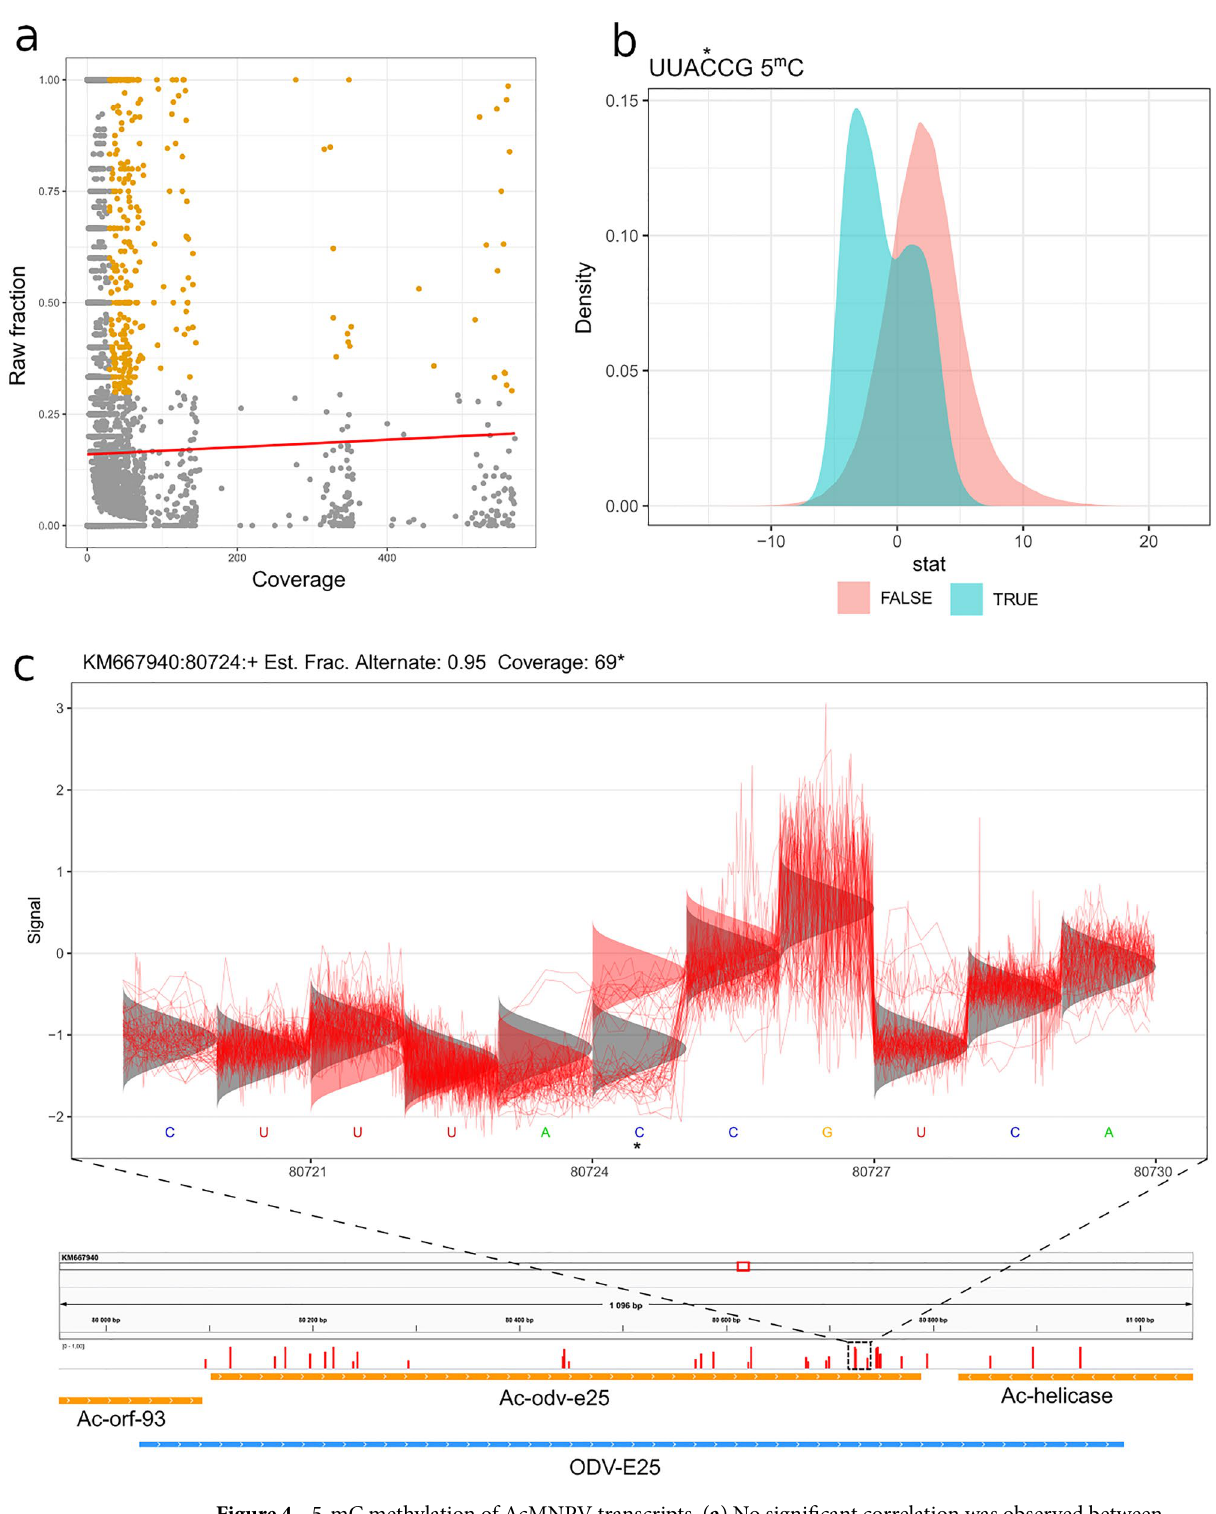
Figure 4. 5-mC methylation of AcMNPV transcripts. ( a ) No significant correlation was observed between the coverage and the number of methylated nucleotides in the raw fraction. Yellow dots indicate positions designated for further analysis. The plot was made with the ggplot2 r package 53 . ( b ) Test statistics of UUAC*CG sequence (methylated positions are labelled by asterisks). This panel plots a distribution of test statistics for motif-matching and non-motif-matching sites for all of the provided motives. The plot was made with the ggplot2 r package 53 . ( c ) A putative methylated cytosine of the readthrough part of ODV-E25 transcript (5-mC labelled by asterisk). The red curves indicate the electric signals, while the densities indicate the alternative signal levels. The plot was made with the tombo 1.5.1 software 44